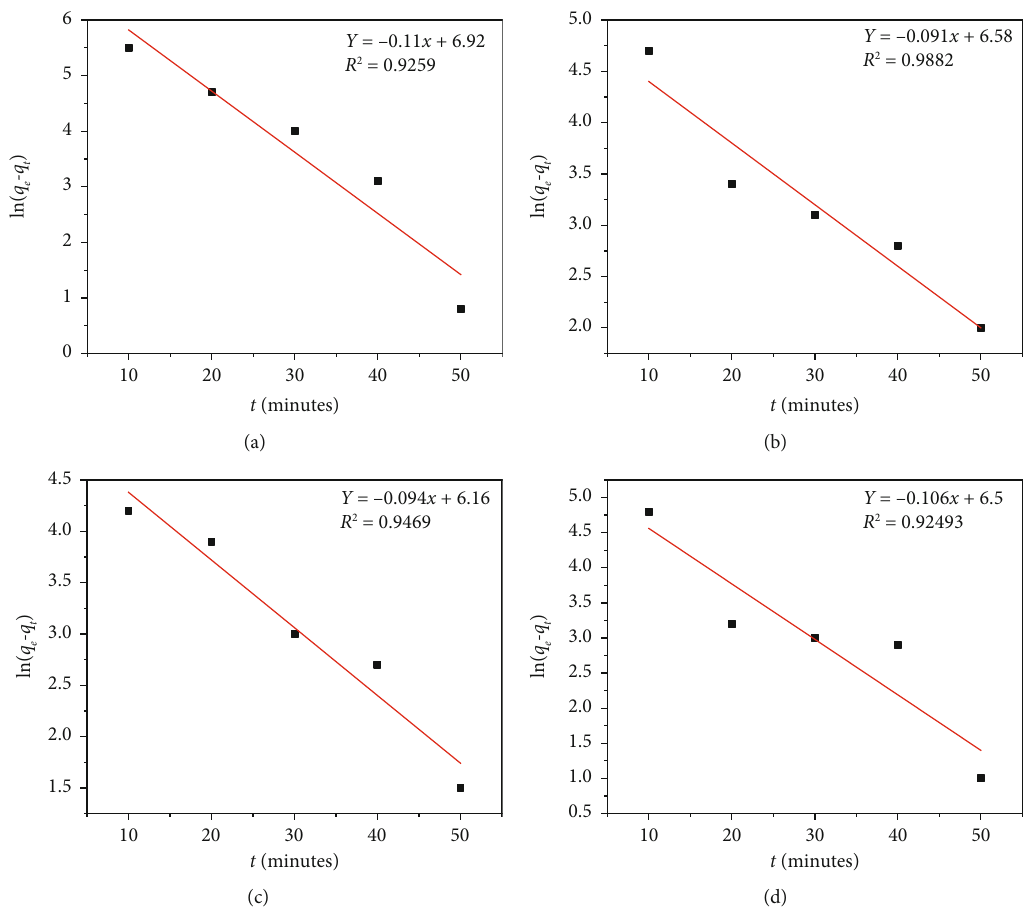
Figure 8: Pseudo- fi rst-order plots for fl uoride adsorption by the adsorbents (a) TAADFP at 450 ° C, (b) TAADFP at 500 ° C, (c) TAADFP at 550 ° C, and (d) TAADFP at 600 °